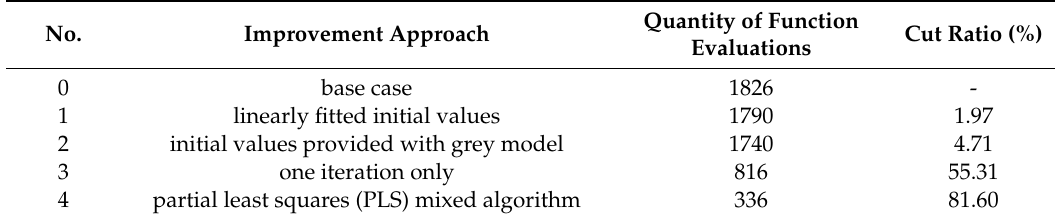
Table 1. Algorithm improvement concerning function